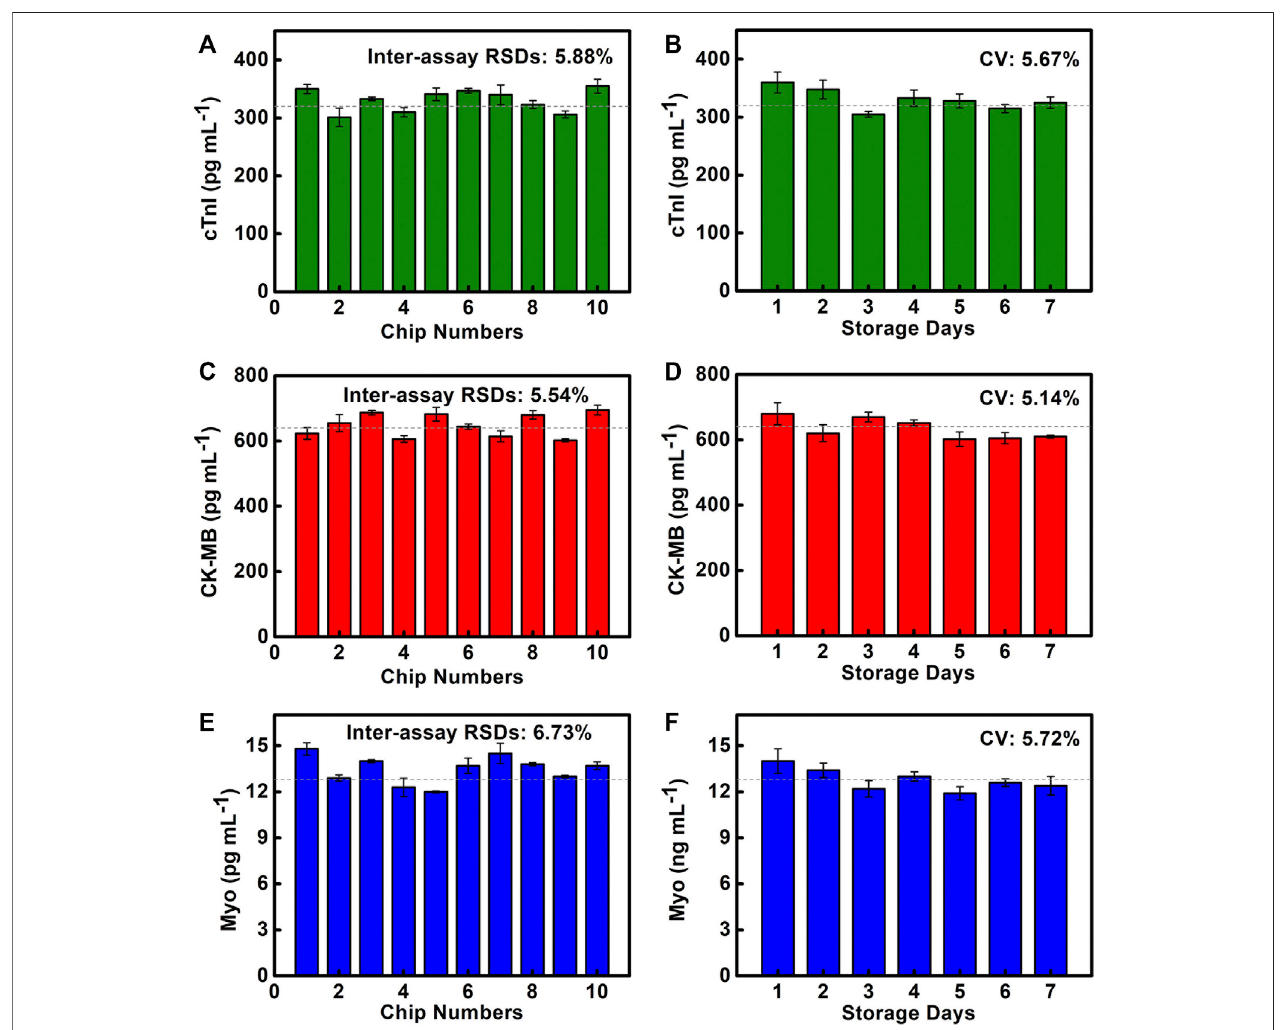
FIGURE5| Reproducibilityandstoragestability ofSMC. (A – C) QuantitativeresultsofcTnI,CK-MB, andMyoaredetected on10SMCs. (D – F) Quantitativeresults of cTnI, CK-MB, and Myo are detected on SMC stored for 1 – 7 days.